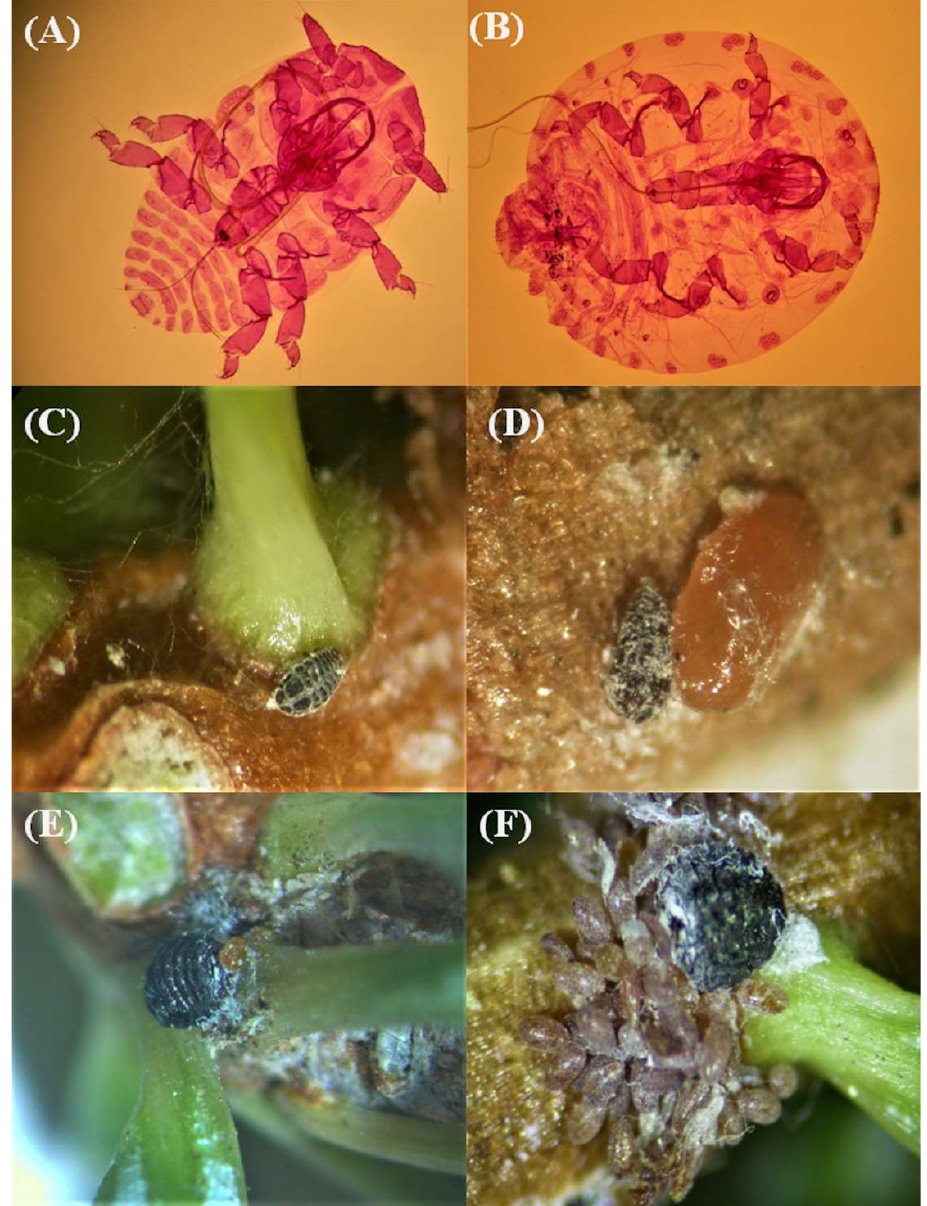
Figure 8. ( A ) Slide-mounted specimen of the 1st instar larva of the neosisten of D. nordmannianae , ( B ) slide-mounted specimen of mature larva of D. nordmannianae , ( C ) first instar larva of the overwintering neosisten of D. nordmannianae , ( D ) living mature larva of D. nordmannianae and P. hellenicus inside the node of Abies spp., ( E ) and ( F ) living mature larva of D. nordmannianae deposits clusters of brownish-orange eggs.